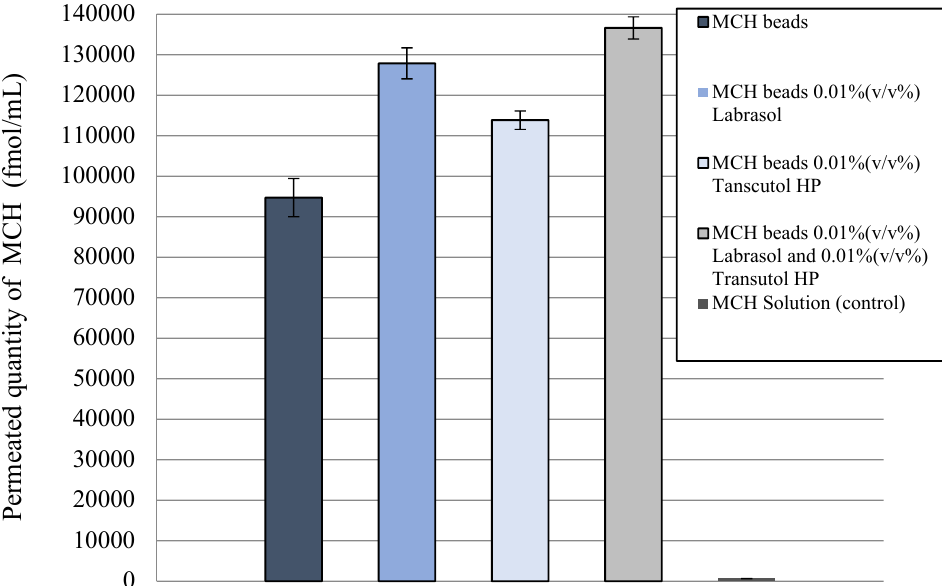
Figure 9. Evaluation of permeability of MCH across Caco-2 epithelial cell layers treated with the different formulations for 1 h. Increased peptide permeability was observed when penetration enhancers were added to the compositions. Each data point represents the mean ± SD, n = 10.